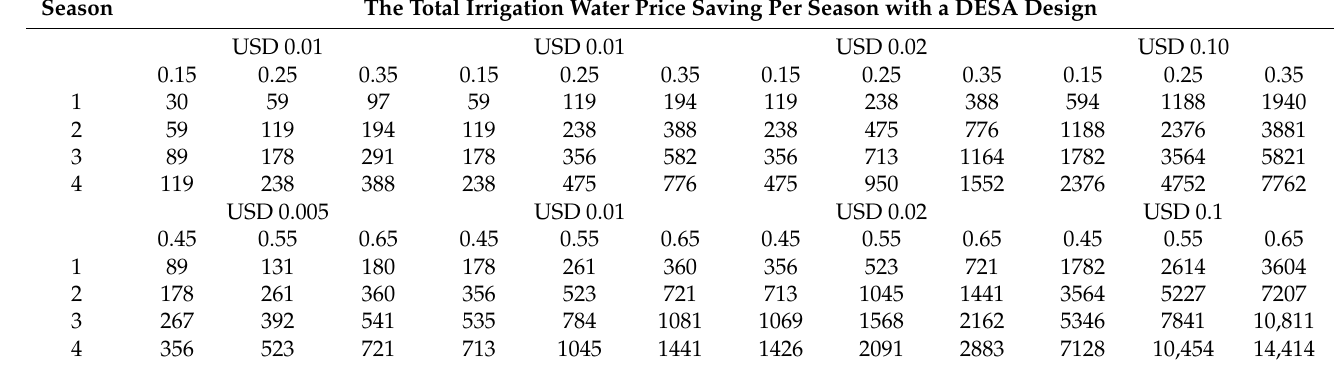
Table 8. Irrigation water saving per season at three percentage assumptions for water-saving by using a DESA design with center pivot irrigation at different water